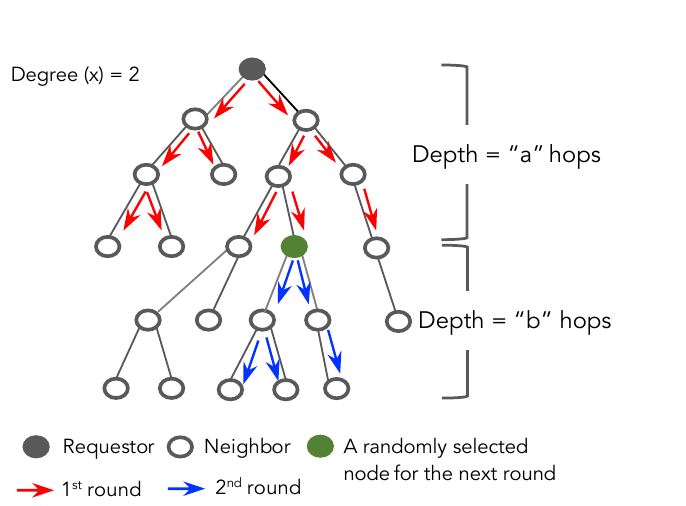
Figure 2. The policy of Random-X-Walker for propagating the query in multiple